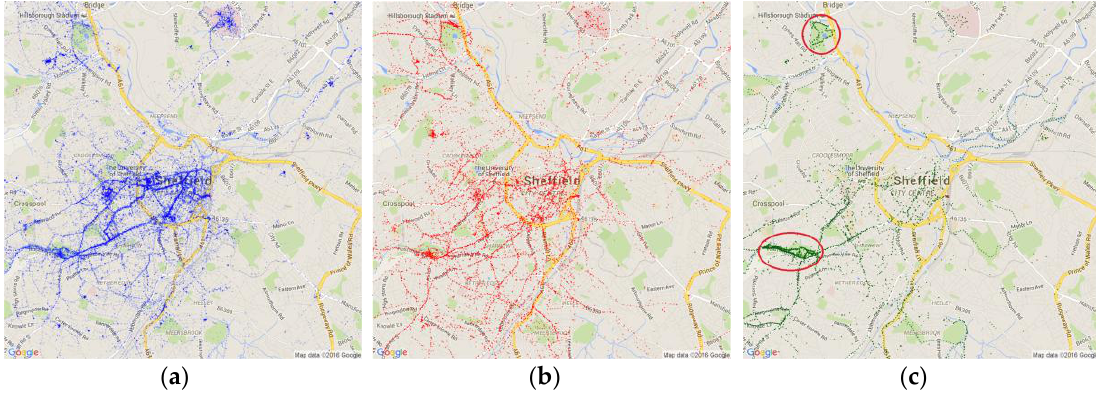
Figure 6. Geographical distribution of ( a ) walking; ( b ) cycling; ( c ) running. parkruns